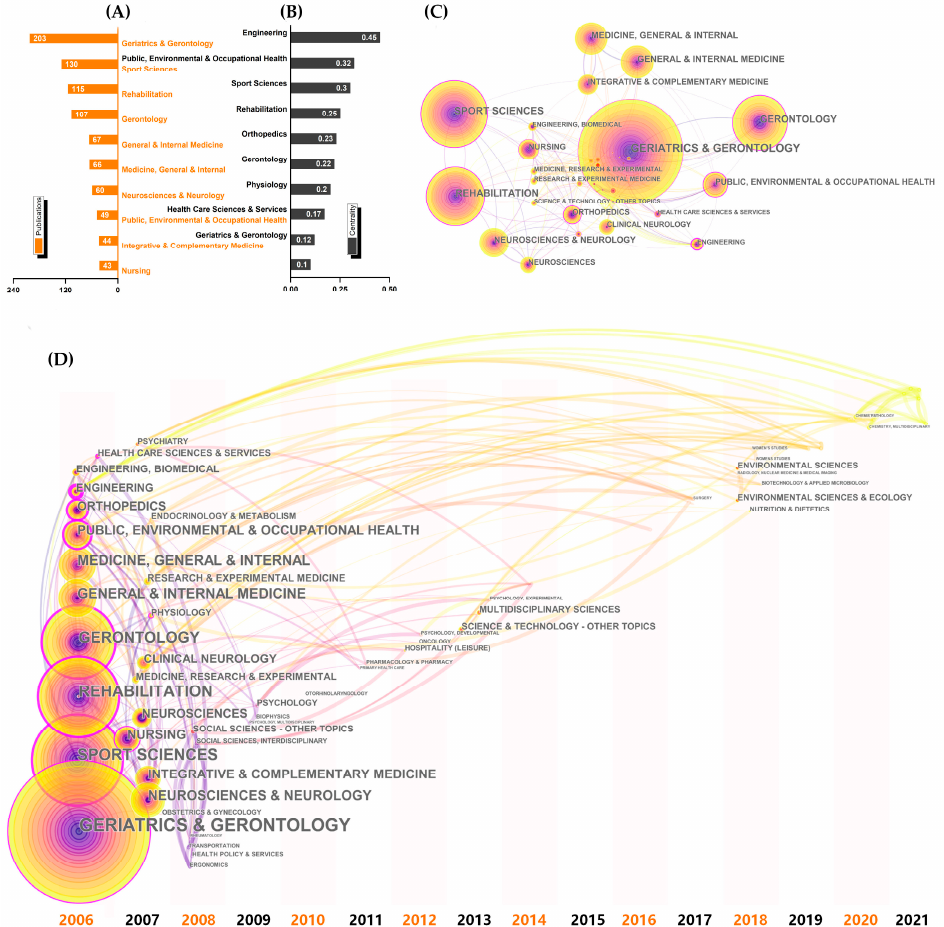
Figure 7. Visualized map of the research categories. ( A ) Top ten research categories by publications; ( B ) top ten research categories by centrality; ( C ) collaboration map of research categories; ( D ) time zone view of research categories.